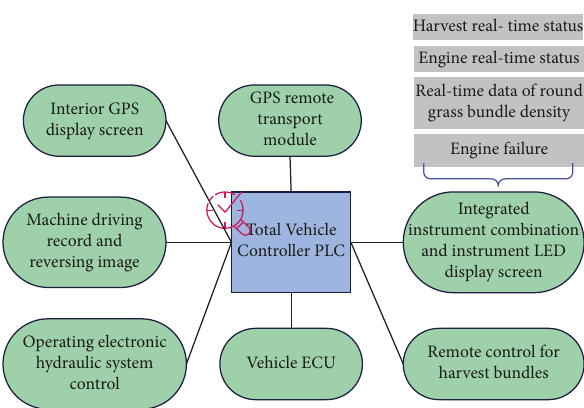
Figure 9: Architecture diagram of the central electronic control and detection and monitoring system of the whole